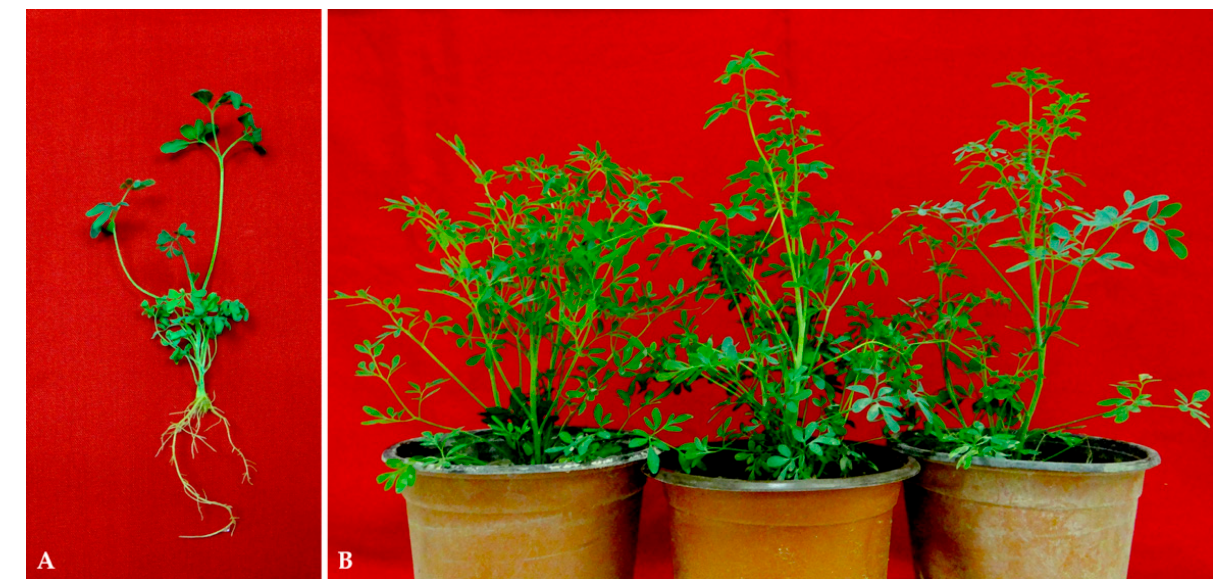
Figure 2. ( A ). In-vitro-rooted plants of R. chalepensis before transplantation ( B ). Ex-vitro-established micropropagated R. chalepensis plants after 4 months of transfer.